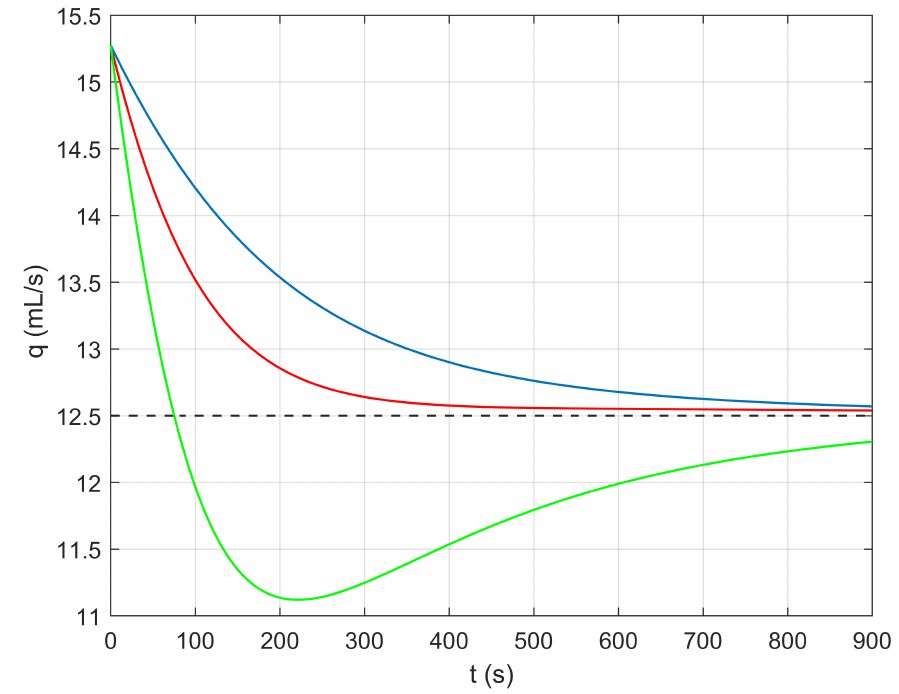
Figure 2. Arterial–arteriolar blood flow rate q time behavior (solid red line for κ 1 = 0.002, κ 2 = 0.01, M 1 = 0.1738, M 2 = 3.46 × 10 − 4 ; solid blue line for κ 1 = 0.002, κ 2 = 0.005, M 1 = 0.1738, M 2 = 3.46 × 10 − 4 ; solid green line for κ 1 = 0.003, κ 2 = 0.01, M 1 = 0.1738, M 2 = 5.19 × 10 − 4 ) and its reference value q n (dashed